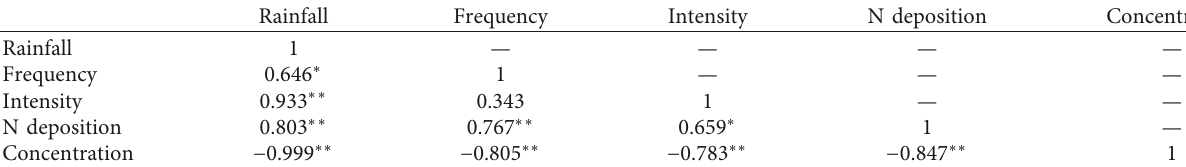
Figure 5: Comparisons of atmospheric TIN w deposition rate listed with other domestic areas. Table 4: Correlation ( R ) between wet N deposition and meteorological conditions.